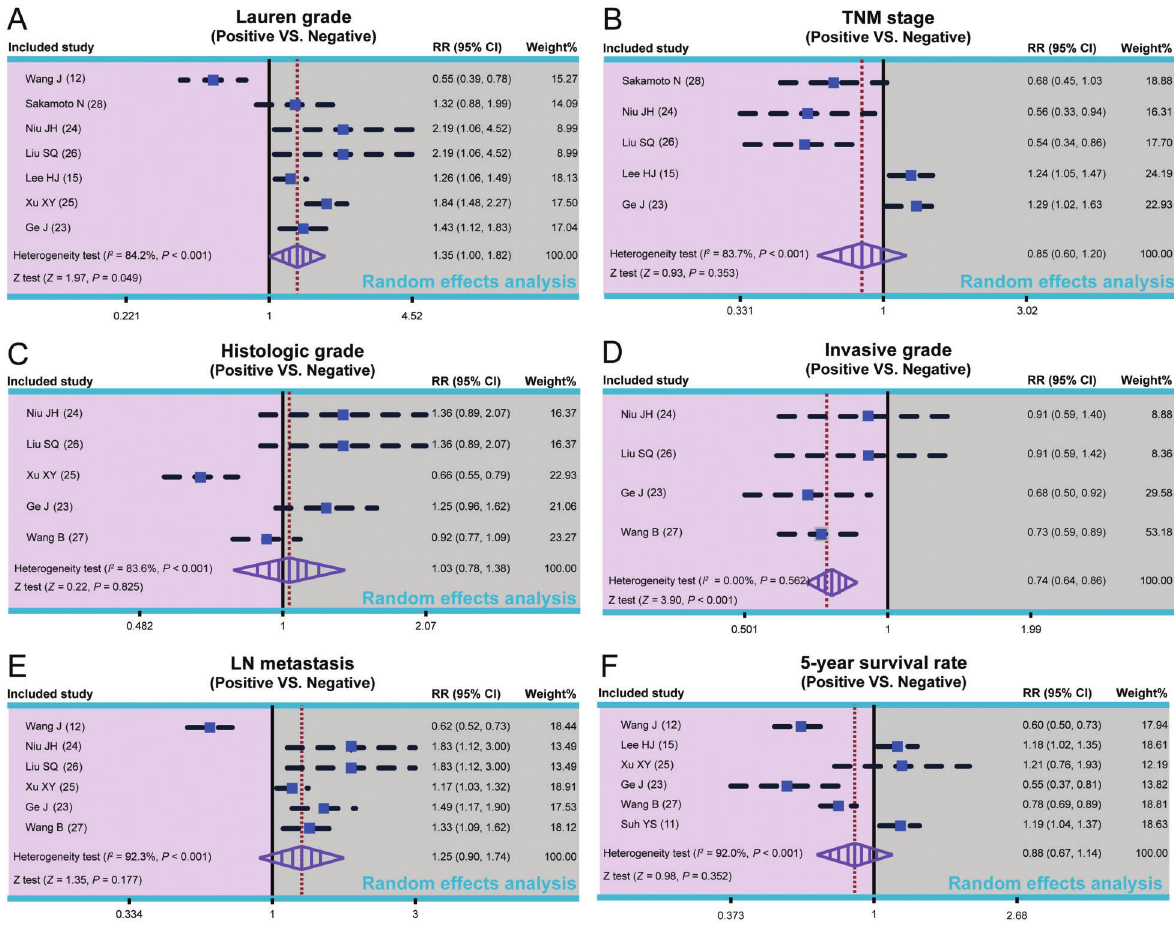
Figure 3. Forest plots of the correlation between cadherin-17 (CDH17) protein expression and the prognosis of patients with gastric cancer (GC).